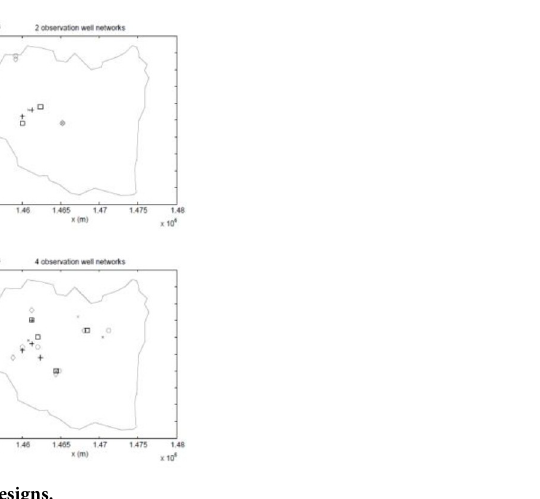
Fig 13. One-, two-, three-, and four-well